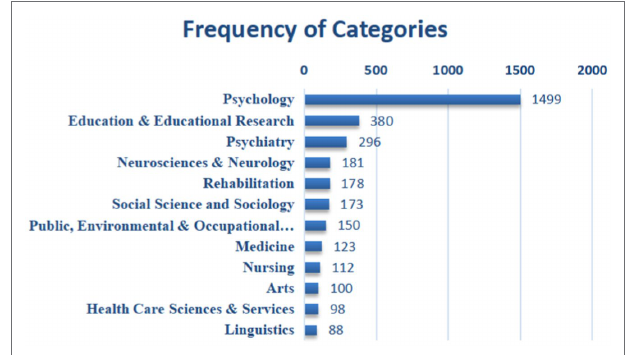
FIGURE 5 | The top 12 categories/disciplines of expressive writing